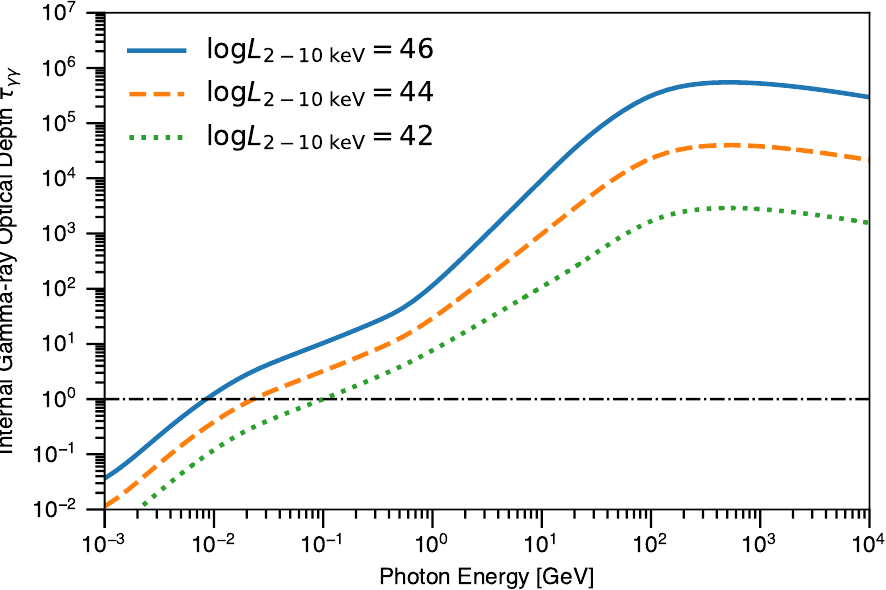
Figure 9. Internal Gamma-ray optical depth in the core region of AGNs. From top to bottom, each curve corresponds to 2–10 keV luminosity of 10 46 , 10 44 , 10 42 erg s − 1 , respectively. The horizontal dot-dashed line represents τ γγ =